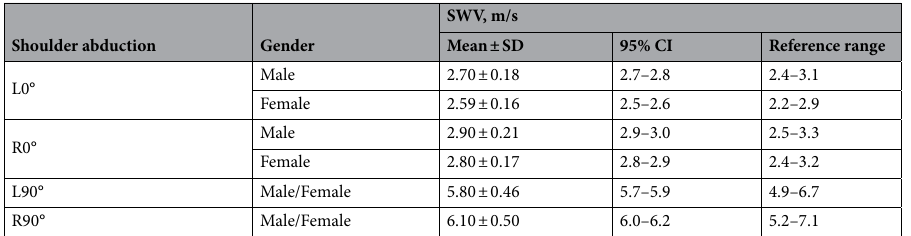
Table 4. Reference ranges of MD elasticity in healthy participants by gender at various arm abduction. SD Standard deviation, MD middle deltoid, SWV mean shear wave velocity, CI confidence interval. L0° left arm